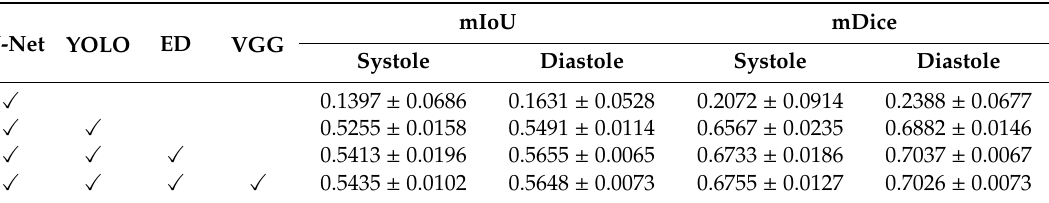
Table 5. Segmentation evaluation by mIoU and mDice for each combination of modules when divided by the ventricular systolic